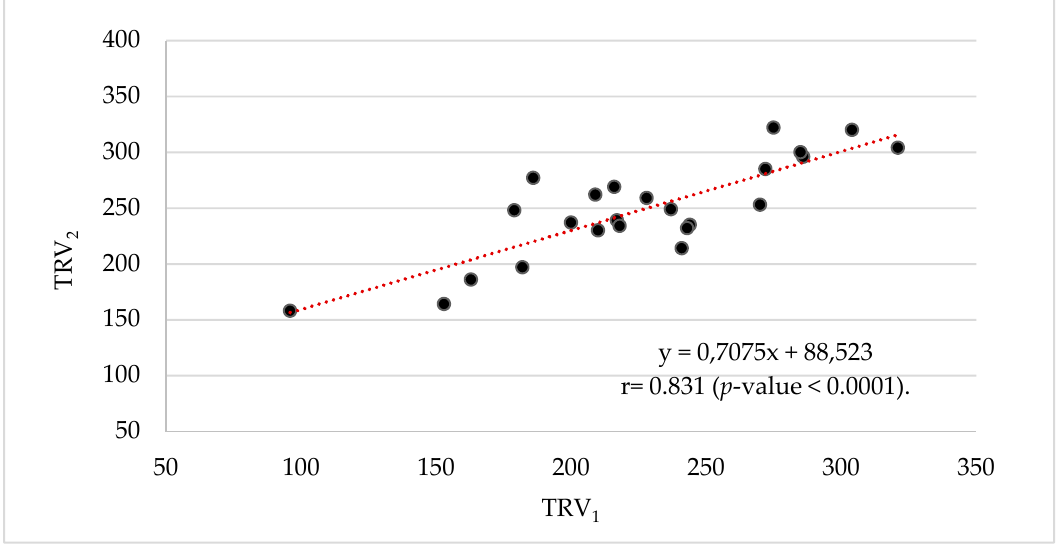
Figure 10. Linear regression graph between TRV 1 and TRV 2.